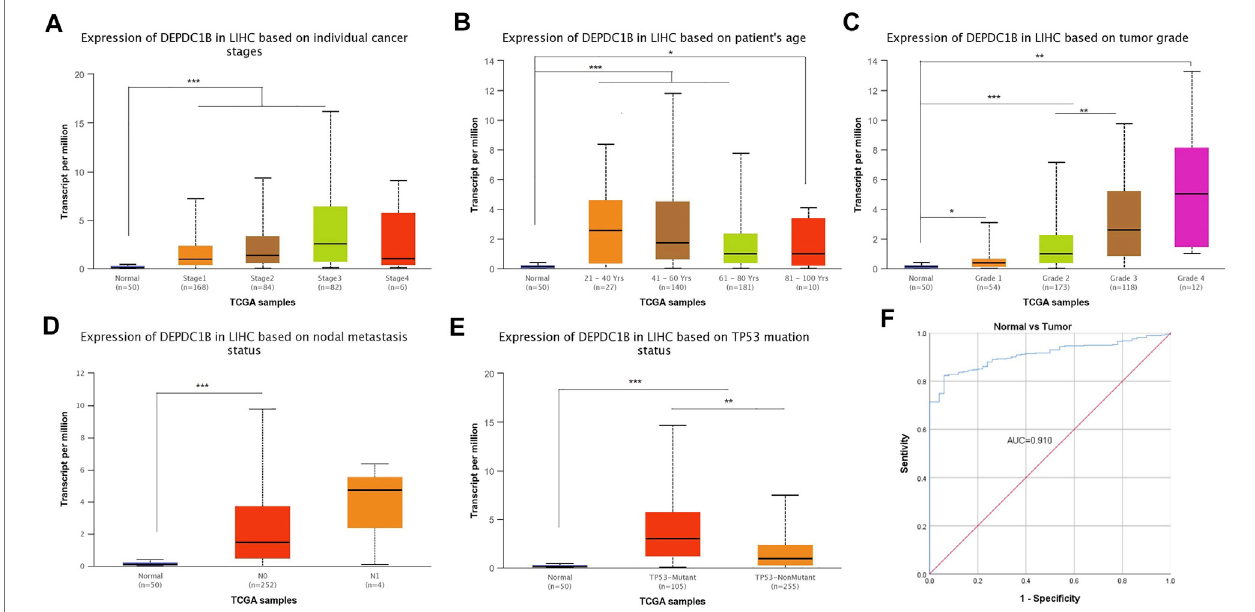
FIGURE 4 | Diagnostical potential of DEPDC1B expression in LIHC. Association between DEPDC1B expression and clinical characters: (A) cancer stage. Normal vs Stage 1, p (cid:1) 1.62e-12; Normal vs. Stage 2, p (cid:1) 3.44e-06; Normal vs. Stage 3, p (cid:1) 2.59e-07; Stage 1 vs. Stage 3, p (cid:1) 2.15e-03. (B) patient ’ s age. Normal vs. Age (21 – 40 Years), p (cid:1) 9.70e-05;Normal vs. Age(41 – 60 Years), p (cid:1) 6.92e-11; Normal vs. Age(61 – 80 Years), p (cid:1) 6.81e-10, Normal vs. Age(81 – 100 Years), p (cid:1) r0.046. (C) tumorgrade.NormalvsGrade1, p (cid:1) 4.80e-02;NormalvsGrade2, p (cid:1) 2.85e-12;NormalvsGrade3, p (cid:1) 8.09e-12;Normal vs. Grade4, p (cid:1) 1.30e-03.Grade2 vs. Grade 3, p (cid:1) 3.30e-03. (D) LIHC nodal metastasis status. Normal vs. N0, p < 1E-12. (E) TP53 mutation status. Normal vs. TP53-Mutant, p < 1E-12; Normal vs. TP53- NonMutant, p (cid:1) 1.99e-11; TP53-Mutant vs. TP53-NonMutant, p (cid:1) 1.94e-03. (F) Diagnosis value of DEPDC1B using ROC analysis. AUC: area under ROC curve. Student ’ s t test was used to generate a p -value. * p < 0.05, ** p < 0.01, *** p <